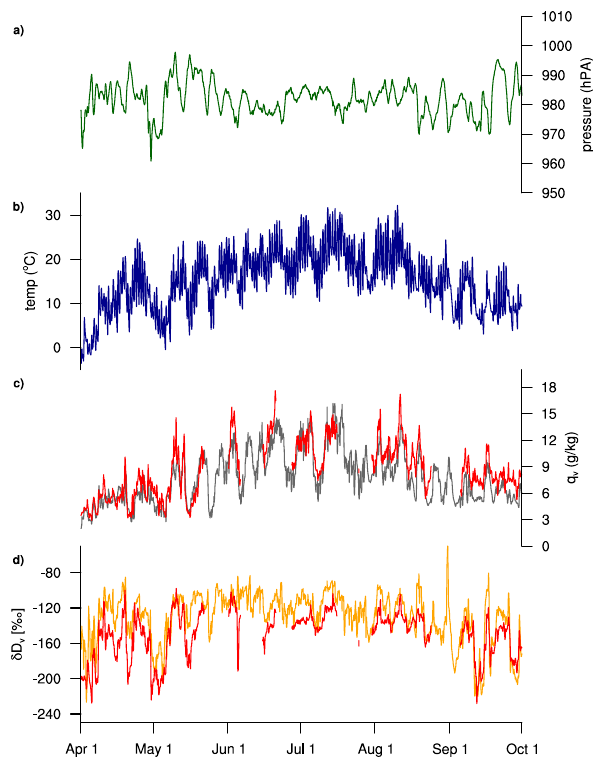
Figure 6. Time series of ECHAM5-wiso simulation values between 1 April and 30 September 2012 of (a) surface pressure (green line), (b) surface temperature (blue), (c) vapour amount q v of the low- est model grid box (grey), (d) δ D of the water vapour (yellow). In panel (c) and (d) the related smoothed PICARRO measurements (red lines) are shown for comparison. The model values are all taken from the grid box enclosing Kourovka